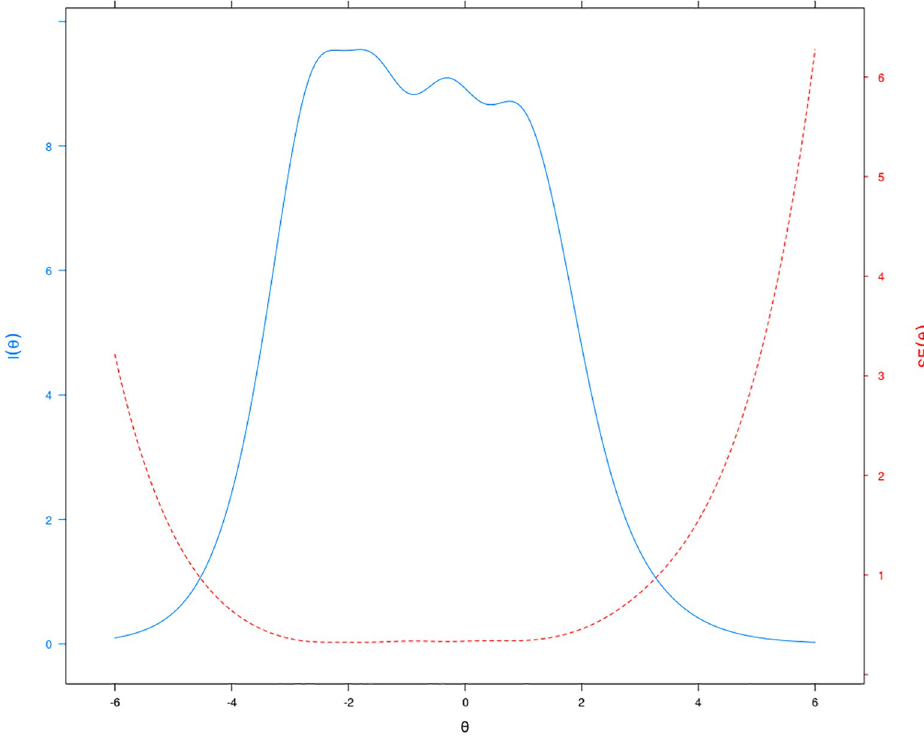
Fig 3. Test information curve of the DFS-Short